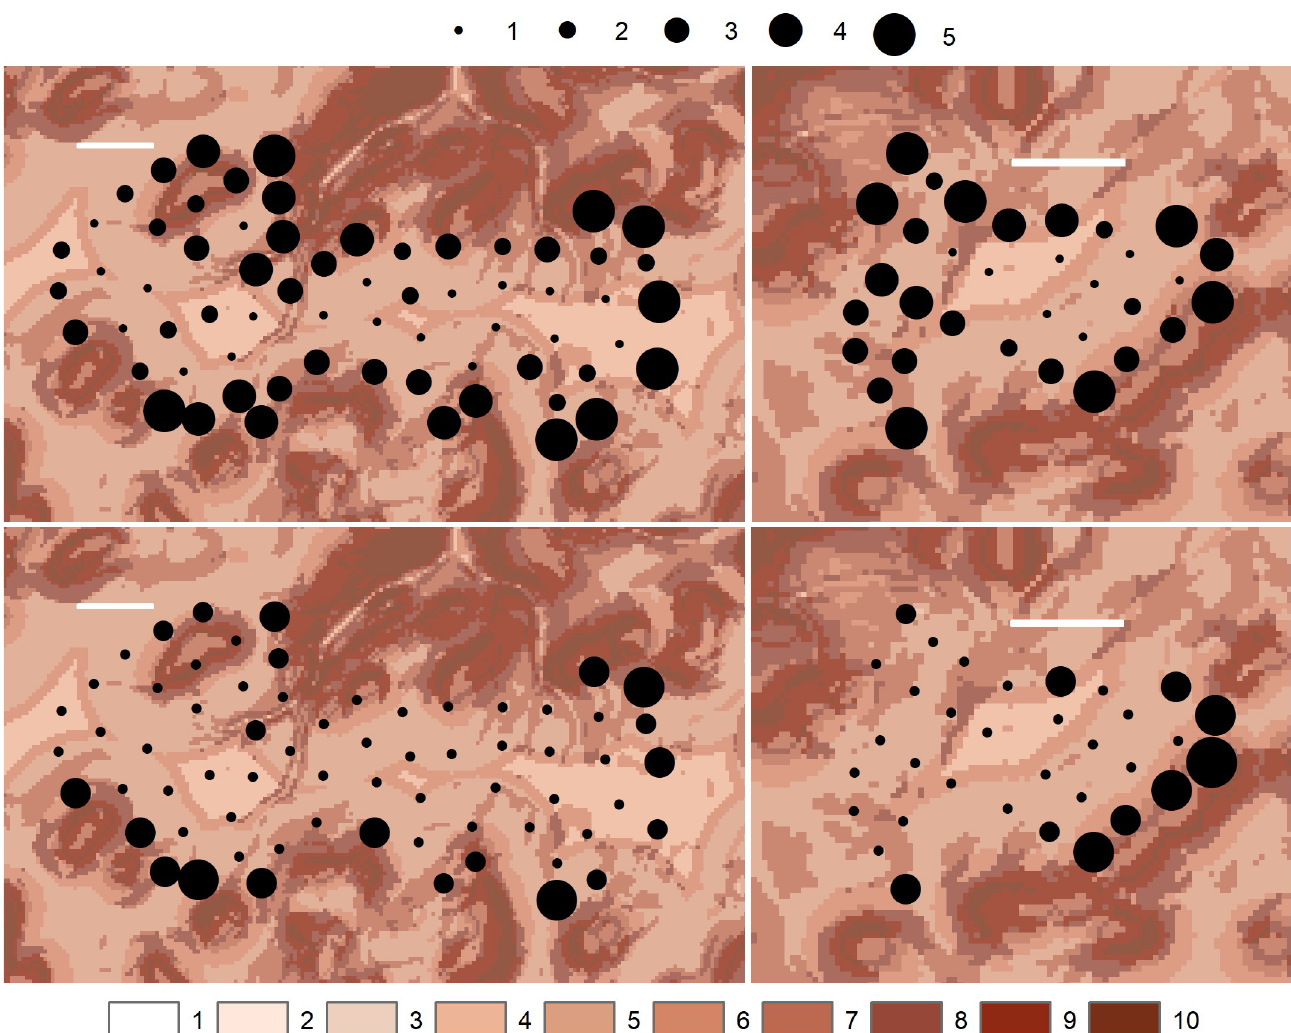
Fig 4. Proportions of eagle tag records at turbine hub locations at Stronelairg (left two panels) and Dunmaglass (right two panels), before and after turbine operation (above and below; by wind farm). Black circles are quantiles (1–5) with larger circles indicating greater proportions of records. The backdrop (1–10) shows the GET score [45] by 50-m pixels in intrinsic habitat preference with a higher score (darker) indicating higher preference. The horizontal white bar is 1 km. Note the relative reduction of records in proximity to ‘inner’ turbine locations after turbine operation and that after turbine operation, golden eagle activity was further restricted to the vicinity of a few ‘outer’ turbines’ locations: Particularly pronounced at Dunmaglass. Contains Ordnance Survey data © Crown copyright and database right